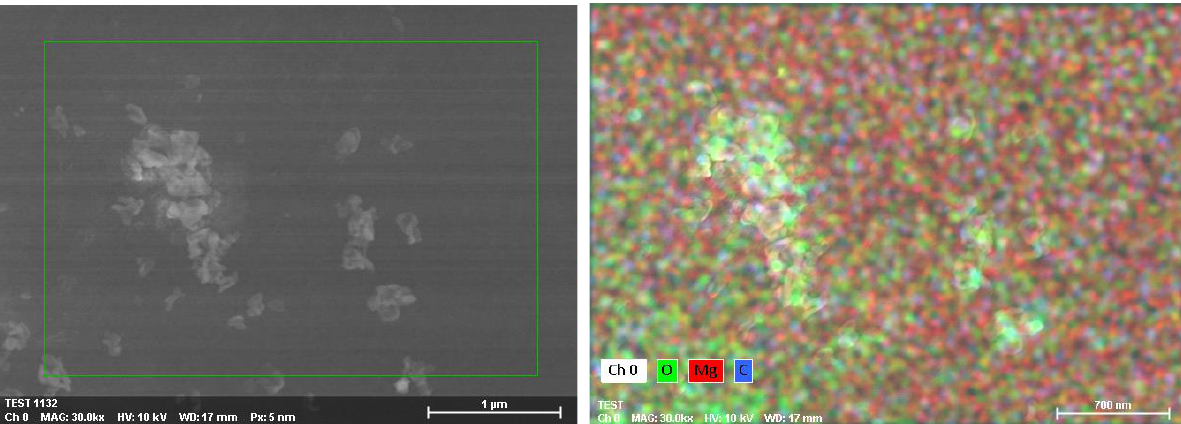
Figure 2. XRD spectrum of pure Mg and in situ MgO/Mg composite ( a ) pure Mg; ( b ) oxidation for 2 min.